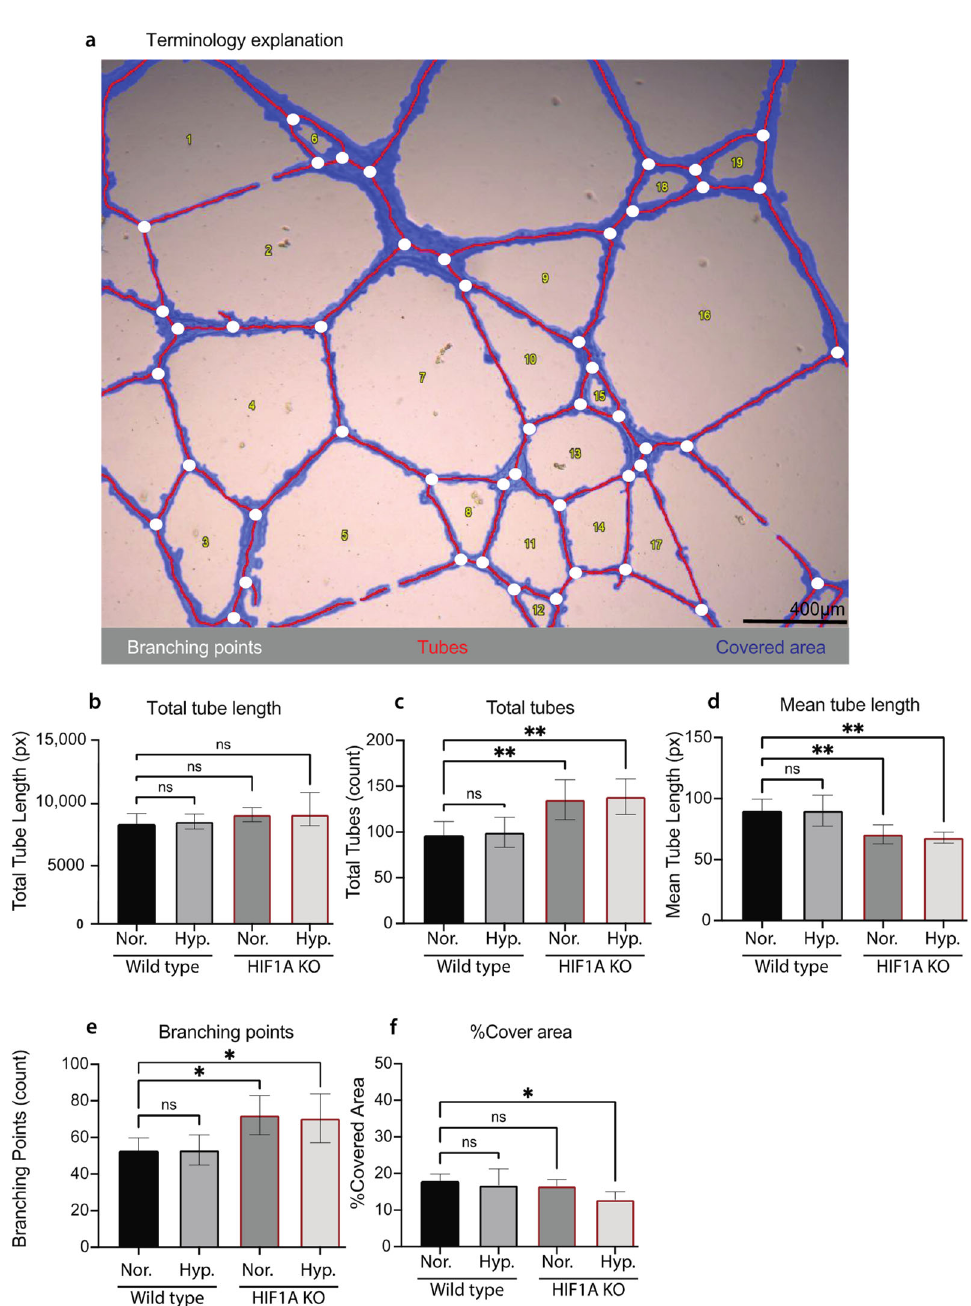
Figure 4. Quantification of the tube formation assay of HIF1A KO and WT HUVECs. ( a ) One representative bright field image of the TFA HUVECs, visualizing the Wimasis terminology which illustrates the tubes in red, the branching points in white, and the covered area in blue. Scale bar 400 µ m. ( b – f ) Quantification of the TFA analysis of HIF1A KO and WT HUVECs cultured in normoxic conditions (Nor.) or 2 h hypoxic conditions (Hyp.). ( b ) The total tube length calculated in pixels. ( c ) The total amount of tubes, (count). ( d ) The mean tube length, (pixels). ( e ) Shows the total branching points, (count). ( f ) The percentage of covered area. The mean of each test ± STD is plotted, and one-way ANOVA with Tukey multiple comparisons test compared each sample group to the WT HUVECs cultured in normoxic conditions (ns = no significance, * p ≤ 0.05, and ** p ≤ 0.01). ( a – f ): Experiments on HUVECs from one biological donor at final p.